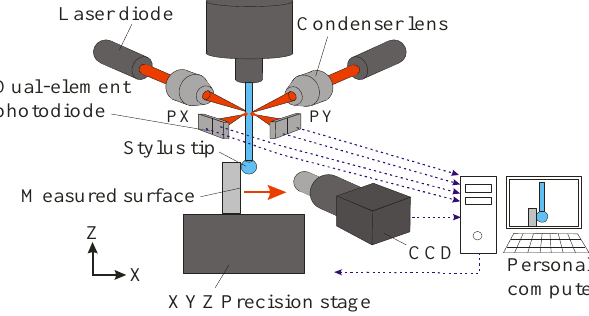
Figure 16. Schematic diagram for evaluating the measurement resolution.